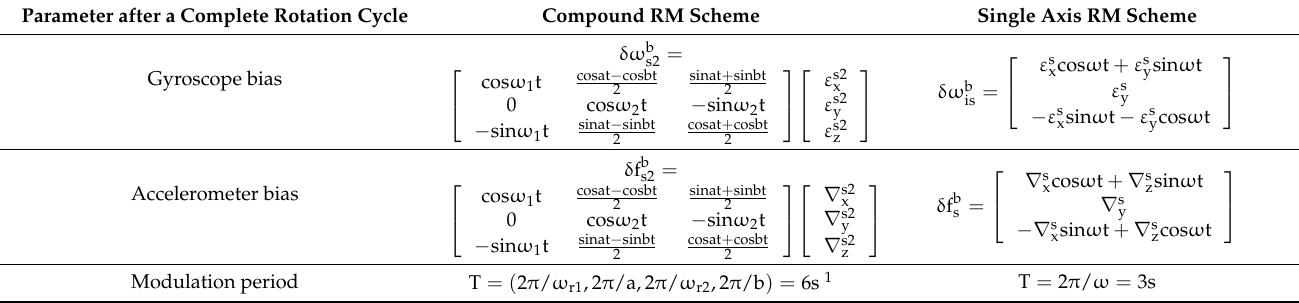
Table 2. Ideal parameters of two rotational modulation